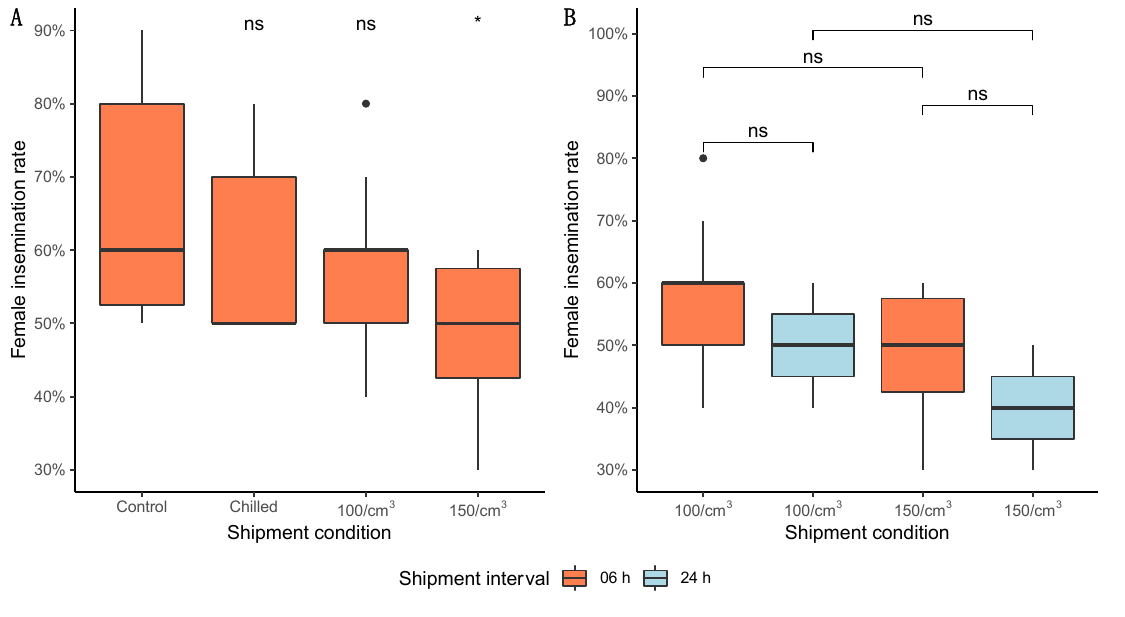
Figure 4. Mean insemination rate Aedes aegypti females after mating with males exposed to different shipment conditions: ( A ) shipment period of 6 h with comparisons always using the control group as reference; ( B ) comparison of 6 and 24 h for both densities (N = 80 females/group; 8 males/group, 240 spermathecae/group). Significance values goes as ‘*’ < 0.05, ‘ns’ < 0.1. Black dots correspond to potential outliers among the samples.